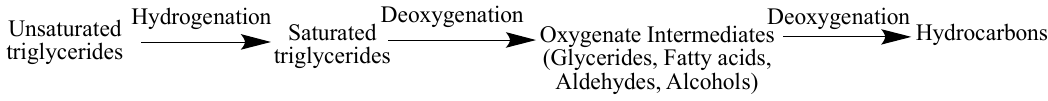
Scheme 1. Simplified reaction pathways during waste cooking oil (WCO) hydrotreating processes.